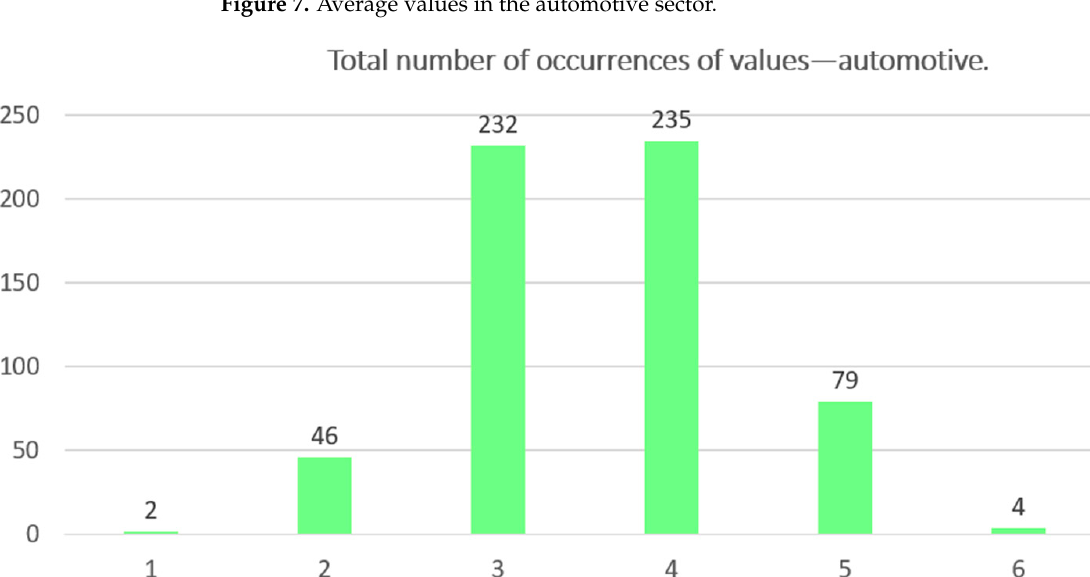
Figure 8. Total number of occurrences of values—automotive .